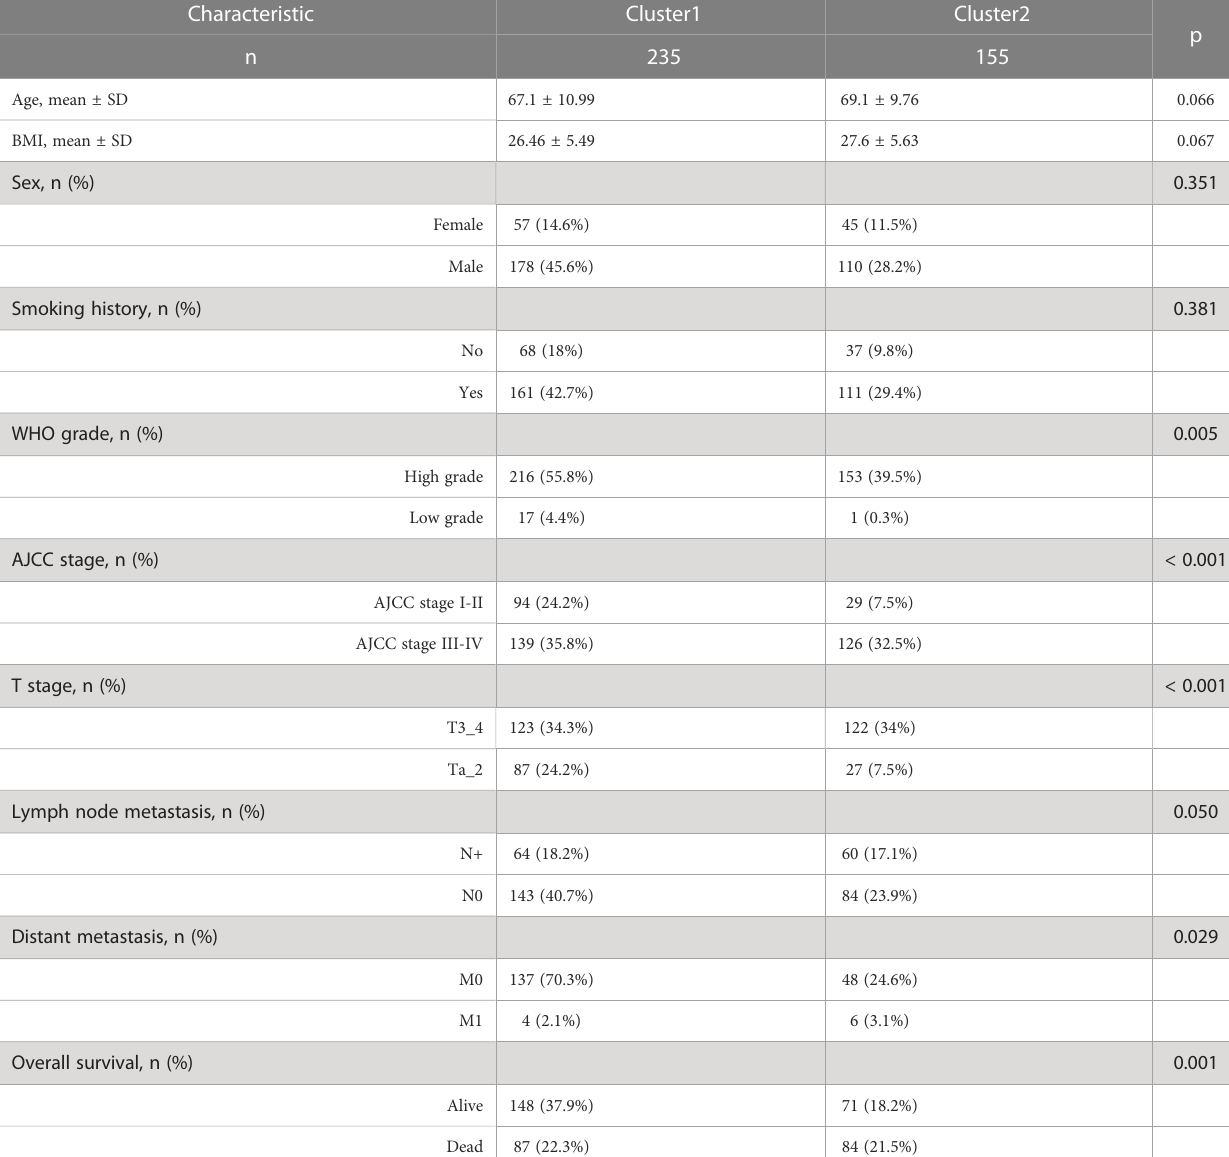
TABLE 1 The clinicopathological characteristics of the TCGA included patients.